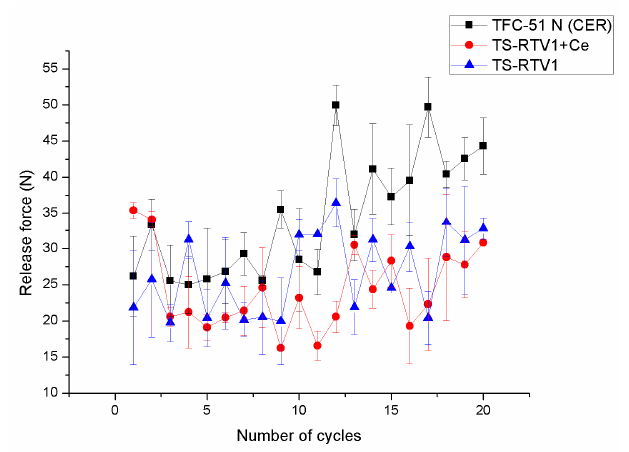
Figure 6. Release force of PUR foam on a flat surface of 45 × 45 mm 2 as a function of the foam cycles analyzed. Non-fluoropolymer coatings.